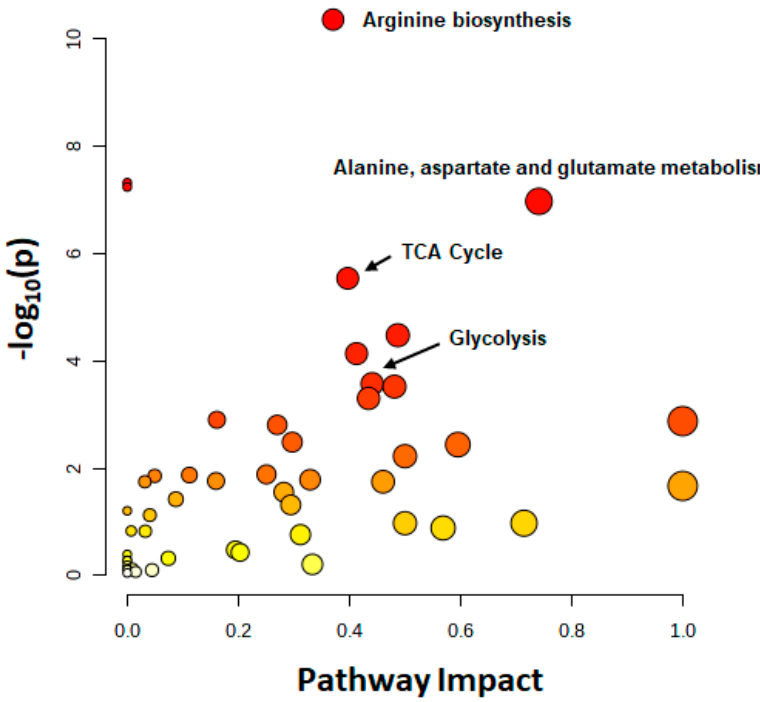
Figure 10. Metabolites Affected in Their 13 C-Enrichment from Glucose by NAT1 KO in Breast Cancer Cells . Metabolic pathways affected by NAT1 KO were detected by the culture of MDA-MB- 231 breast cancer cells with [U- 13 C]-glucose for 24 h. Results of quantitative pathway enrichment analysis of metabolites detected by 2DLC-MS. The arginine biosynthesis, alanine, aspartate and glutamate metabolism, and the TCA cycle were the most affected pathways.